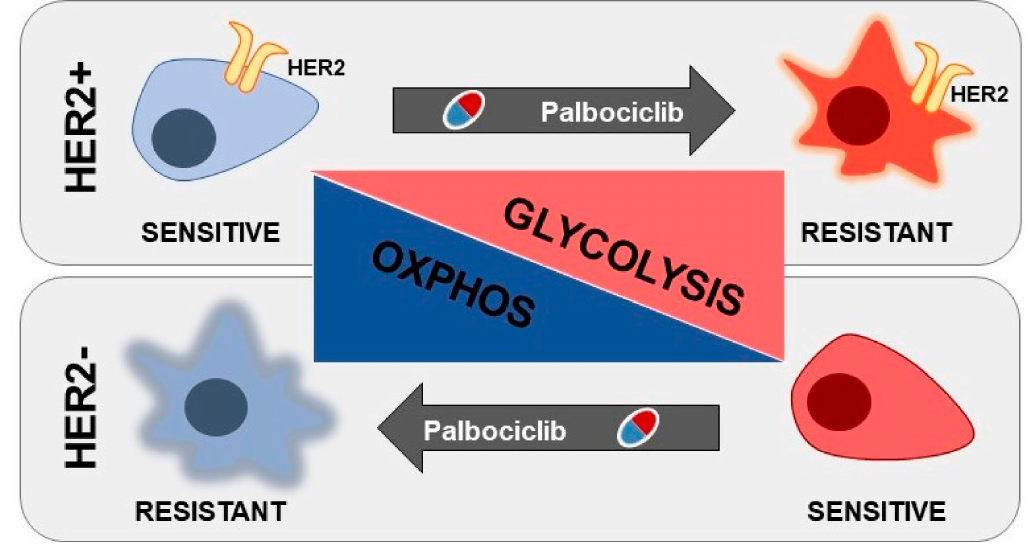
Figure 9. Graphical representation of the central carbon metabolic reprogramming during palbociclib resistance in ER + / HER2 + and ER + / HER2 − breast cancer